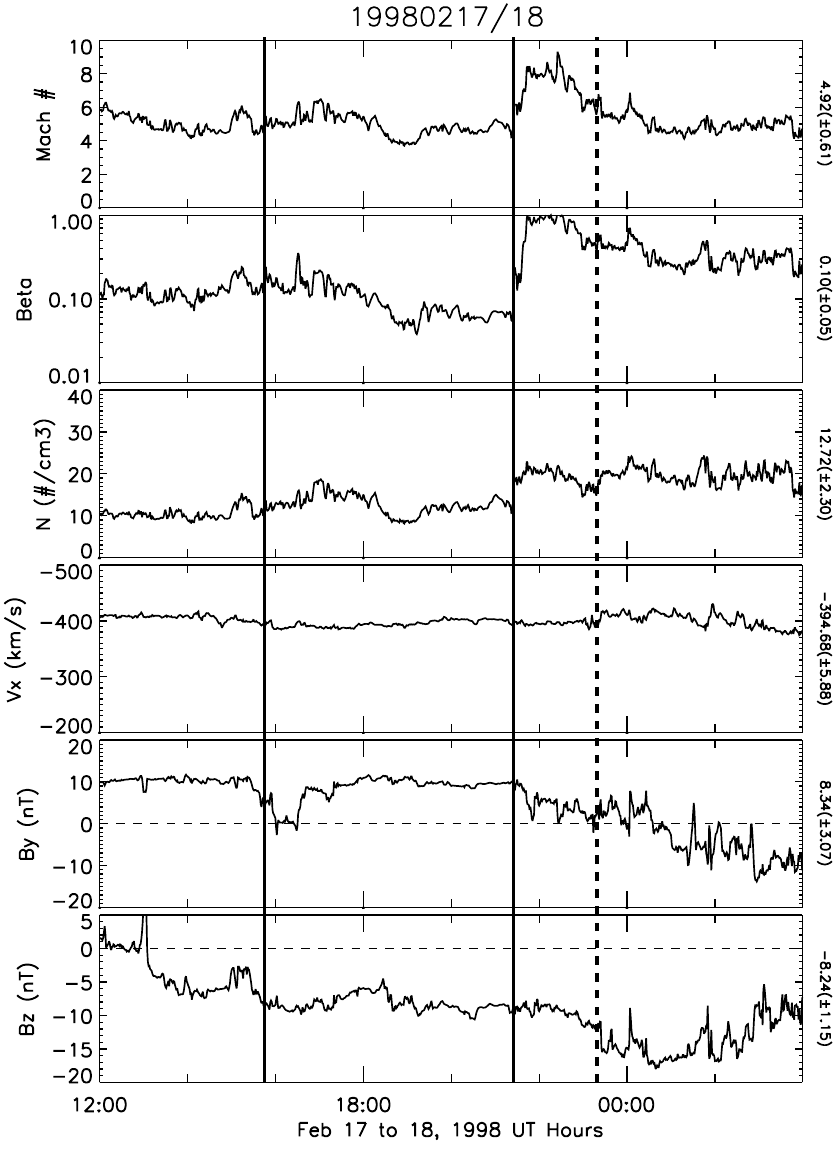
Fig. 10. Propagated ACE data for the BRI on 17 February 1998 (Event 4). The set up is the same as Figs. 3, 5, and 7. Once again, the solid vertical lines represent the beginning and the ending of the BRI, and the dotted line is the substorm at 23:19UT.